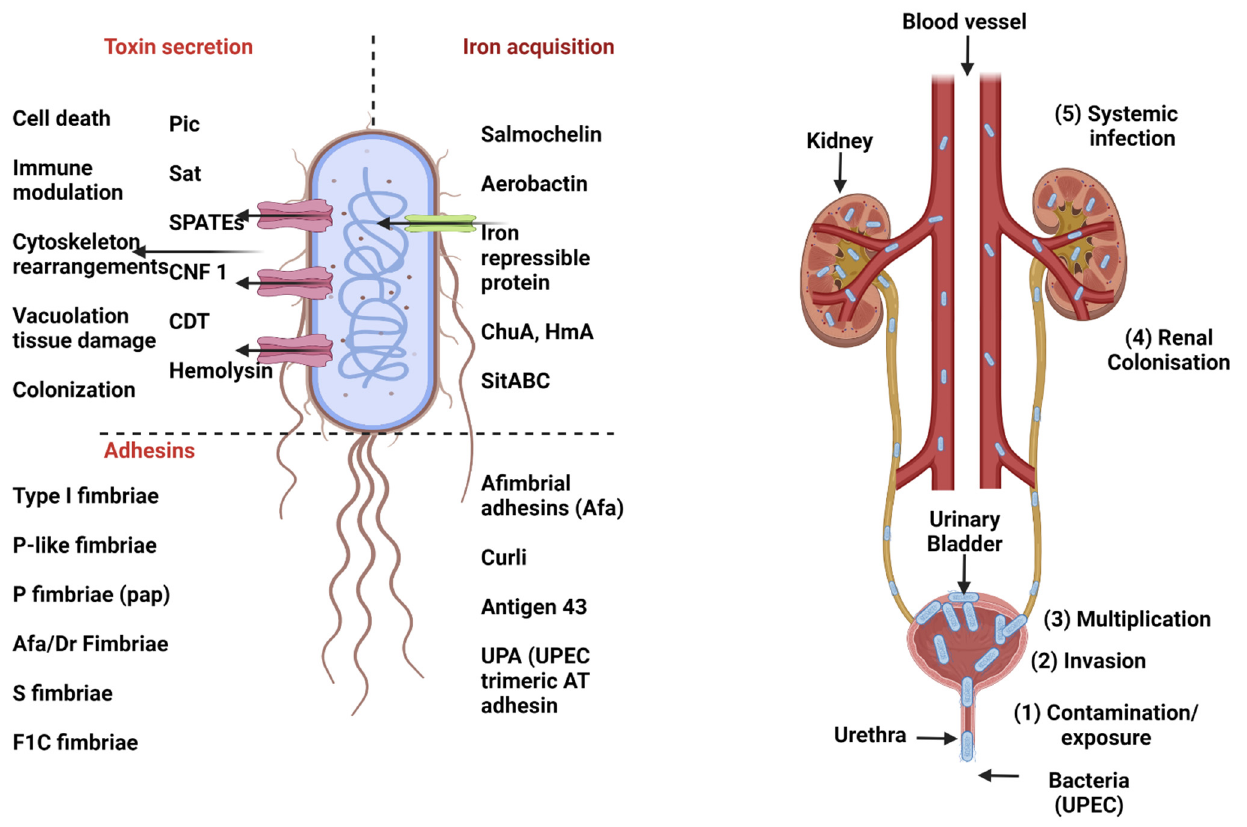
Figure 3. Virulence factors and pathogenesis of UPEC. UPEC possess an array of virulence factors that are distinct from those found in the intestinal pathotypes and hence allow them to colonize extraintestinal sites. Adherence is the first stage of colonization mediated by adhesins such as Type 1 fimbriae, P fimbriae, curli, and outer membrane adhesins. Each adhesin has a specific host receptor. For example, type 1 fimbriae recognize manno-oligosaccharides present on glycoprotein molecules, and P fimbriae recognize the digalactoside component of P blood group antigen present in uroepithelial cells. UPEC produce other adhesins such as Dr adhesins, F1C fimbriae and S fimbriae. Type 3 and F9 fimbriae have been associated with the formation of biofilm and catheter-associated UTIs. Iron is scarce inside the host, but UPEC can glean host iron through high-affinity siderophores including salmochelin, C-glycosylated derivatives of enterobactin, and the hydroxamate siderophore, aerobactin. The presence of heme uptake systems in UPEC helps them to acquire a readily available iron source in vivo, heme. Iron binding receptors Hma and ChuA bind to heme and the coordinated molecule is transported into the periplasm; ChuT mediates further transfer to the cytoplasm through an ATP-binding cassette (ABC) transporter. UPEC can also produce hemolysin (HlyA), cytotoxic necrotizing factor 1 (CNF 1) and autotransporter proteases such as Sat, Tsh, Vat, TagBC, and Sha. In ascending urinary tract infection (UTI), bacteria colonize the urethra and ascend to the bladder leading to cystitis (1) and sometimes subsequently the kidneys resulting in pyelonephritis (4). Bacteria adhere to the bladder surface via type 1 fimbriae which can also mediate cell invasion (2) and replicate (3) within the cell cytoplasm. When the bacteria reach the kidneys (4) there is increased risk of septicemia (5). The figure was created with BioRender.com. (accessed on 22 Jan-